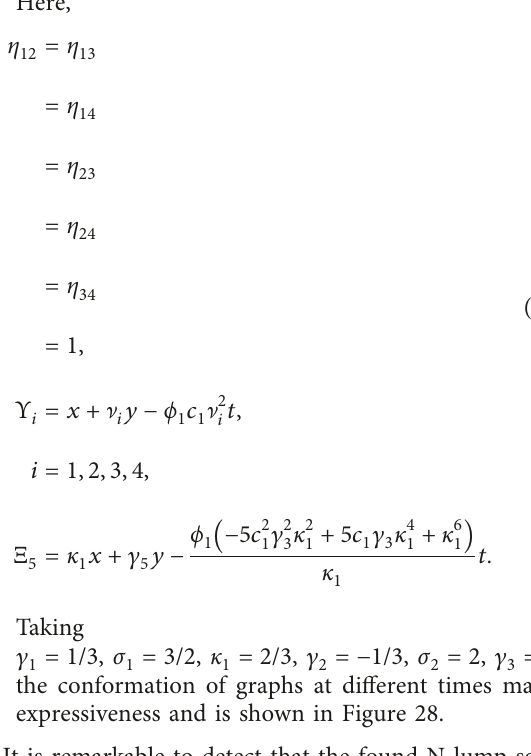
( t ) � 1 , ϕ ( t ) � cos ( t + 3 ) , c 1 9